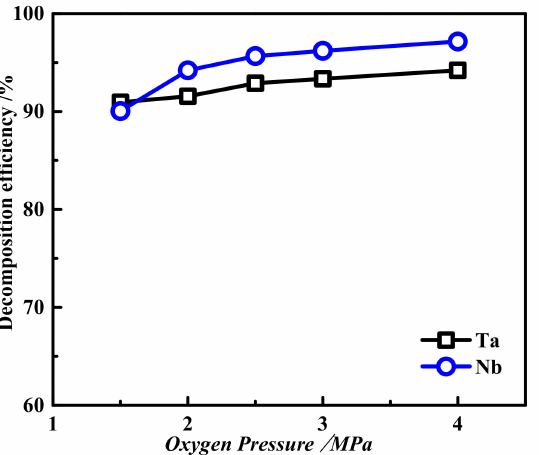
Figure 5. The effect of oxygen partial pressure on the decomposition efficiencies of tantalum niobium: reaction time 2 h, reaction temperature 200 ◦ C, liquid–solid ratio 7:1, and basicity 40